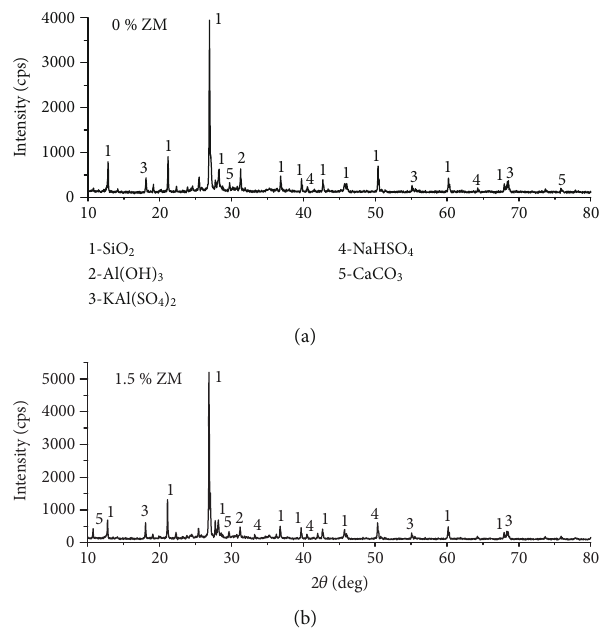
Figure 8: X-ray di ff raction results for specimens with di ff erent ZM concentrationsafter seven daysof curing:(a)0% ZM and(b) 1.5%ZM.